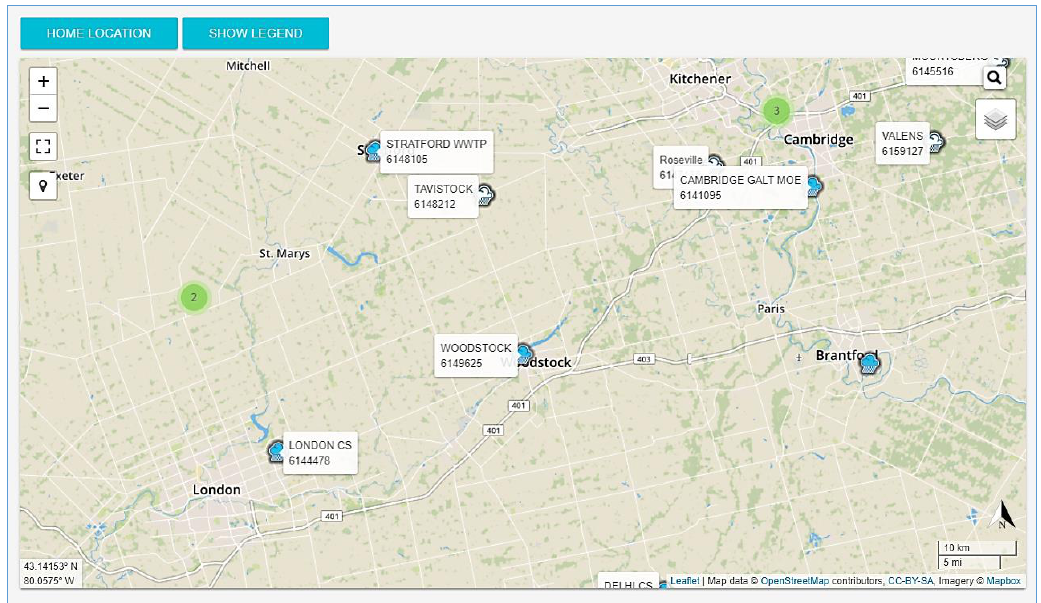
Figure 7. Stations map: Environment and Climate Change Canada (ECCC) (in blue).